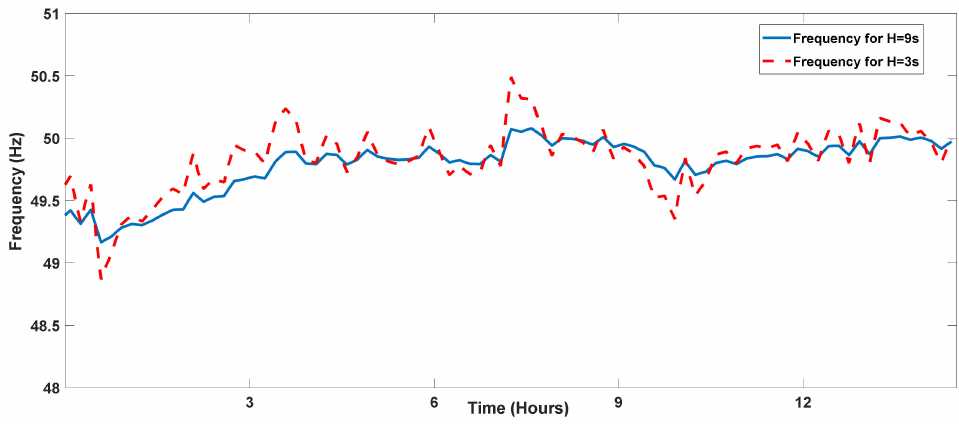
Figure 17. Actual